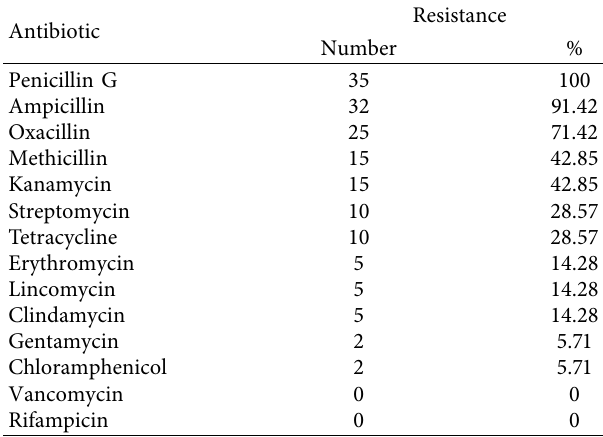
Table 3: Antibiotic resistance pattern in S. aureus strains isolated from row cow